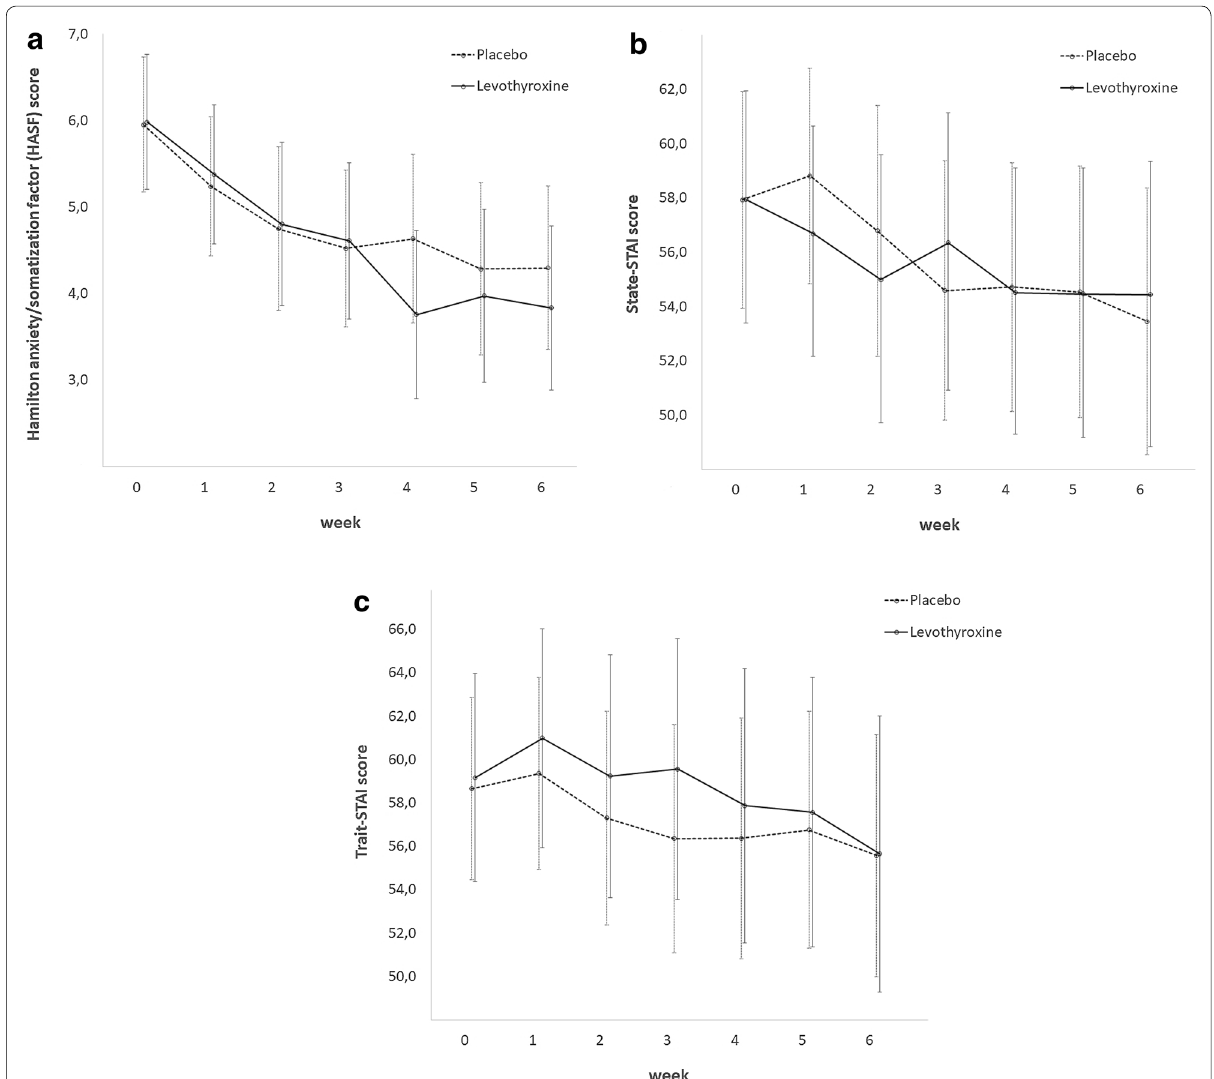
Fig. 1 Course of anxiety symptoms during 6-week treatment of bipolar depression in both treatment groups (L-T4 vs placebo). a Change of Hamilton anxiety/somatization factor (HASF) score. b Change of State-STAI score. c Change of Trait-STAI